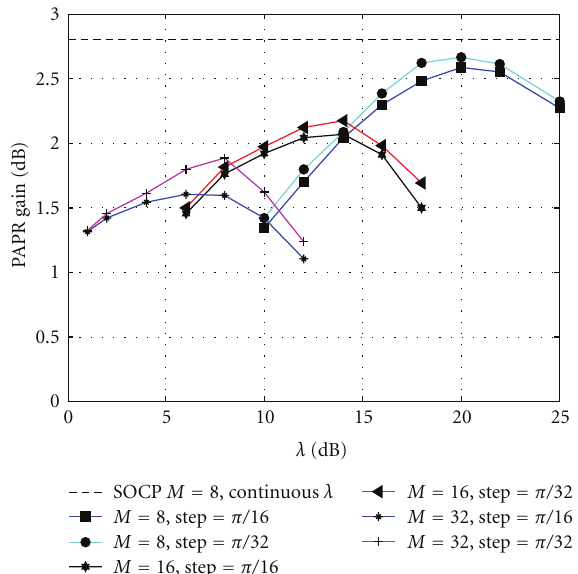
Figure 12: CCDF performance as a function of λ and M , 16-QAM.